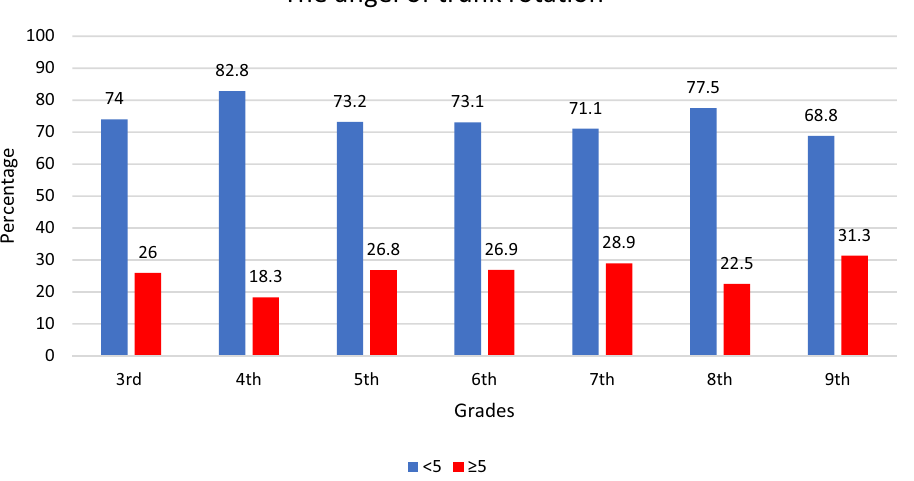
Figure 1. Percentages of children with the angel of trunk rotation < 5° and ≥ 5° according to school